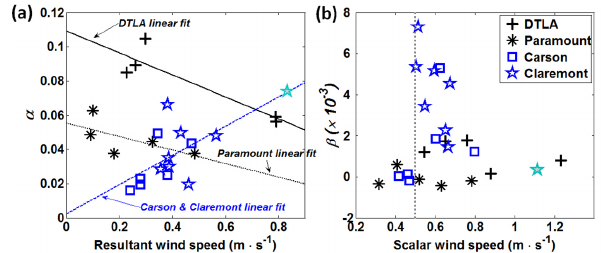
Figure 6. Plots of the relationships of concentration gra- dient ( 1 [UFP] peak ) at the peak with (a) α and (b) β . Dotted line in plot (a) is an exponential curve fit: α = 0.14 · exp( − 3.64 × 10 − 5 . · 1 [UFP] peak ) ( R 2 = 0.59). Black dotted line and blue dash-dotted line in plot (b) are linear fits for overpass ( R 2 = 0.63) and underpass ( R 2 = 0.67) freeway transects,